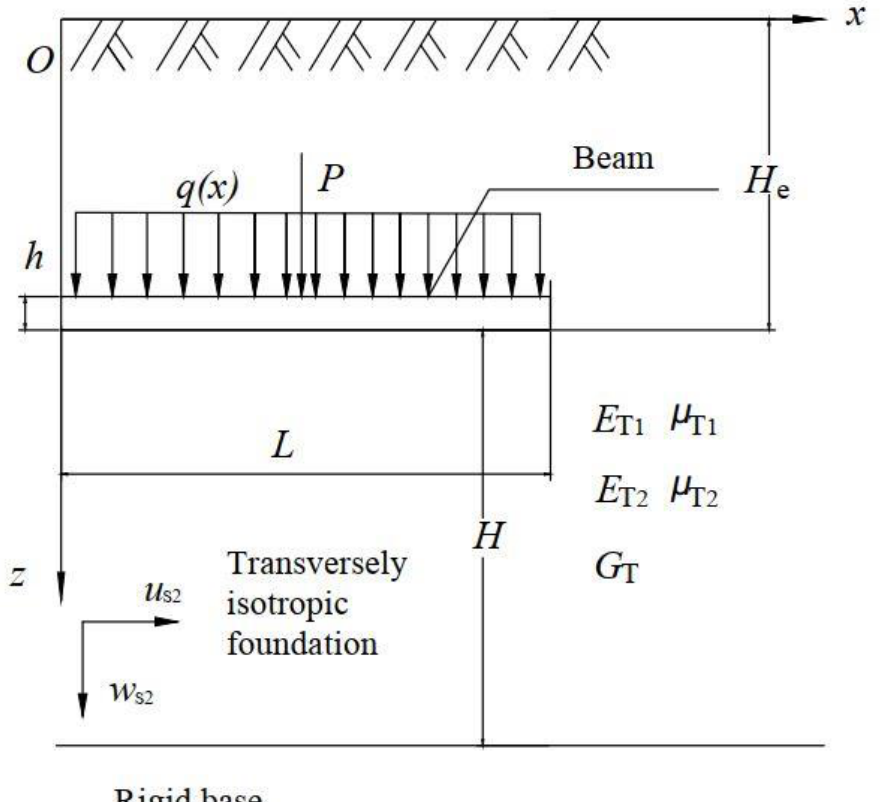
Figure 2. A finite-length beam embedded in a transversely isotropic foundation.